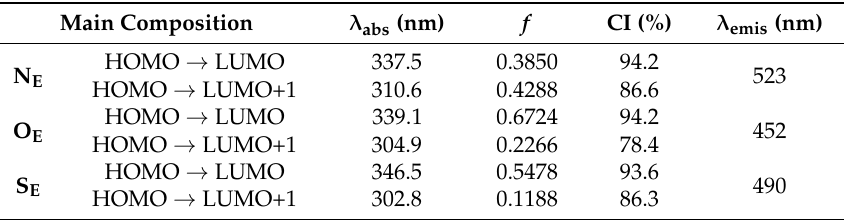
Theoretical absorption wavelength ( λ abs ), Oscillator strength ( f ), contributions (CI), and theoretical emission wavelength ( λ emis ) of N E , O E , and S E ,